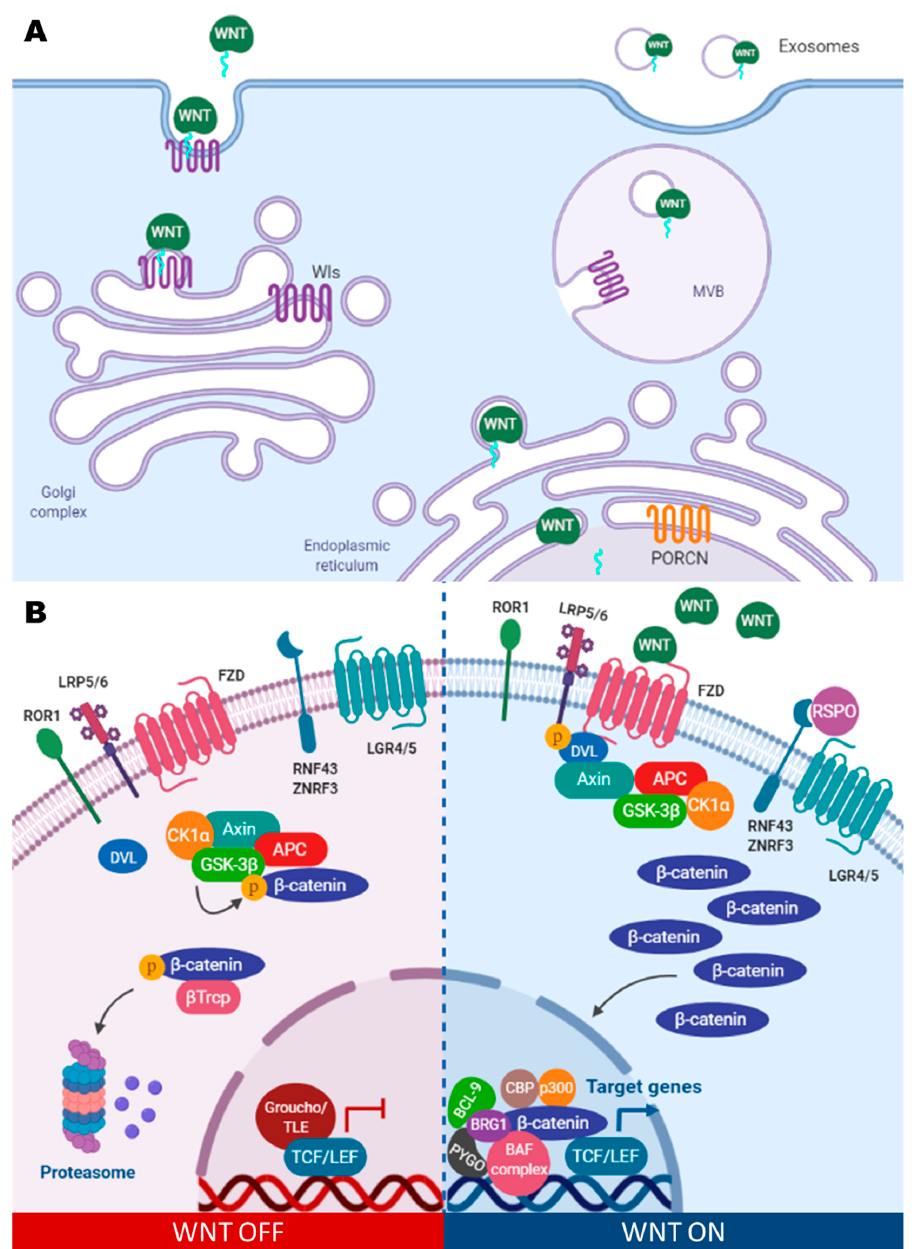
Figure 1. The WNT signaling pathway. ( A ) Scheme of the synthesis and secretion of WNT ligands. At the endoplasmic reticulum, PORCN adds the acyl group palmitic acid to WNT ligands, so that Wls proteins bind to them and transfer them to the plasma membrane. On the right is one of the mechanisms of WNT ligand secretion proposed in the literature, the secretion of WNT ligands through exosomes or extracellular vesicles. ( B ) Scheme of the WNT/ β -catenin signaling path- way. On the right, the pathway is activated when WNT ligands bind to FZD and LRP5/6 receptors, activating DVL which inactivates the β -catenin destruction complex formed by Axin, APC, CK1 α and GSK-3 β . As a result, β -catenin accumulates in the cytoplasm and eventually translocates to the nucleus, where it binds to different co-activators and the TCF/LEF transcription complex to activate transcription of WNT target genes. On the left, in the absence of WNT ligands, the de- struction complex phosphorylates β -catenin, which is then recognized by β -Trcp ligase, which marks β -catenin to be de- graded at the proteasome.